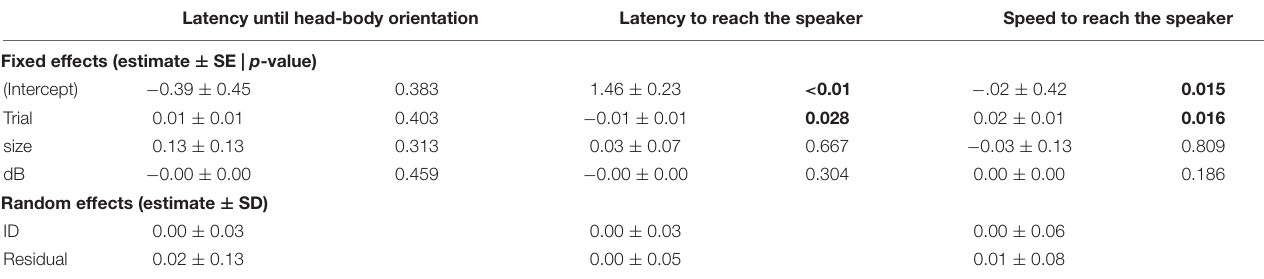
TABLE 1 | Mixed effect model